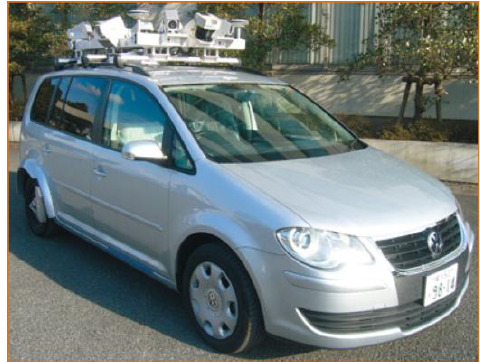
Figure 1. This van is equipped with a Mitsubishi MMS mobile mapping system, showing its cameras, laser scanners and three GPS antennas mounted together on its roof platform. (Source: Mitsubishi